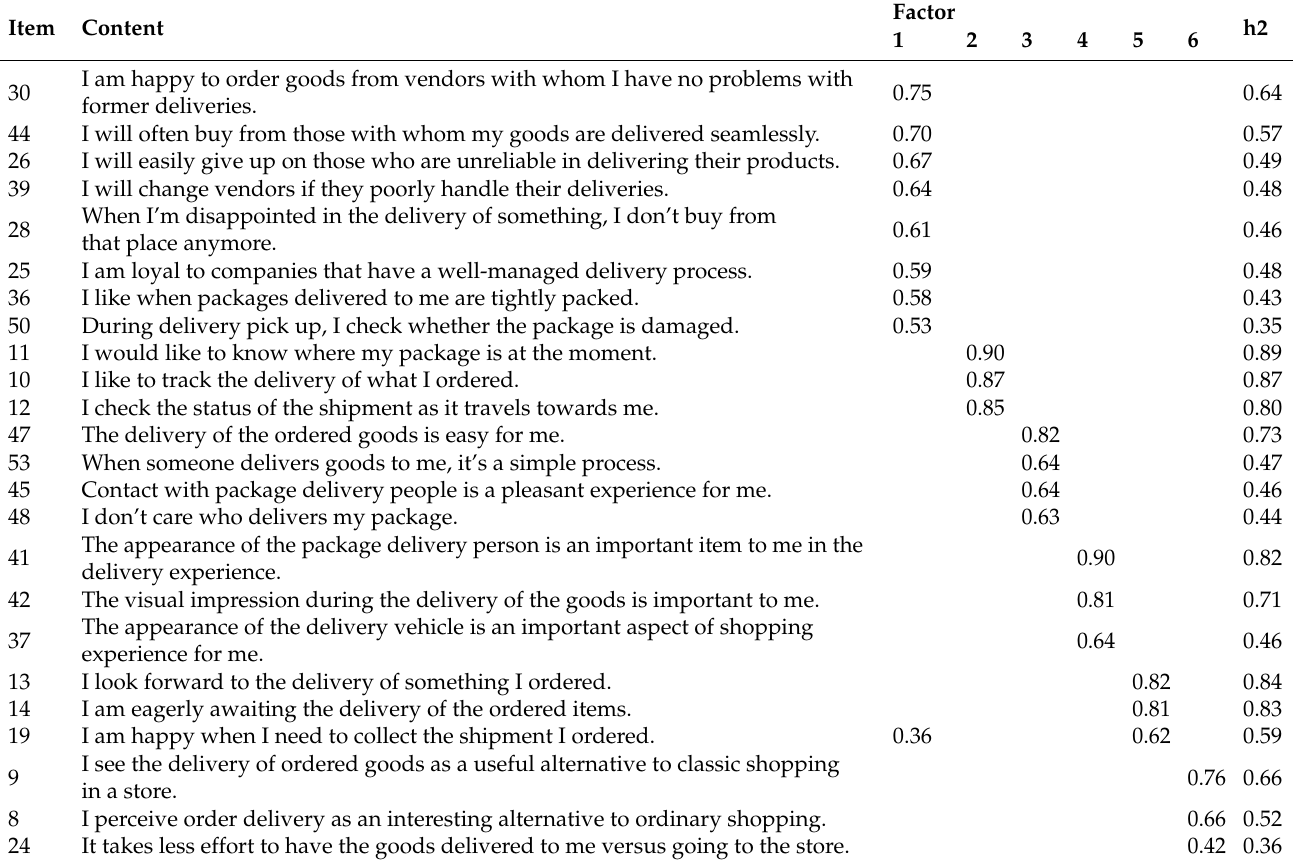
Table 2. Pattern matrix of the six-factor solution in EFA ( n = 453).